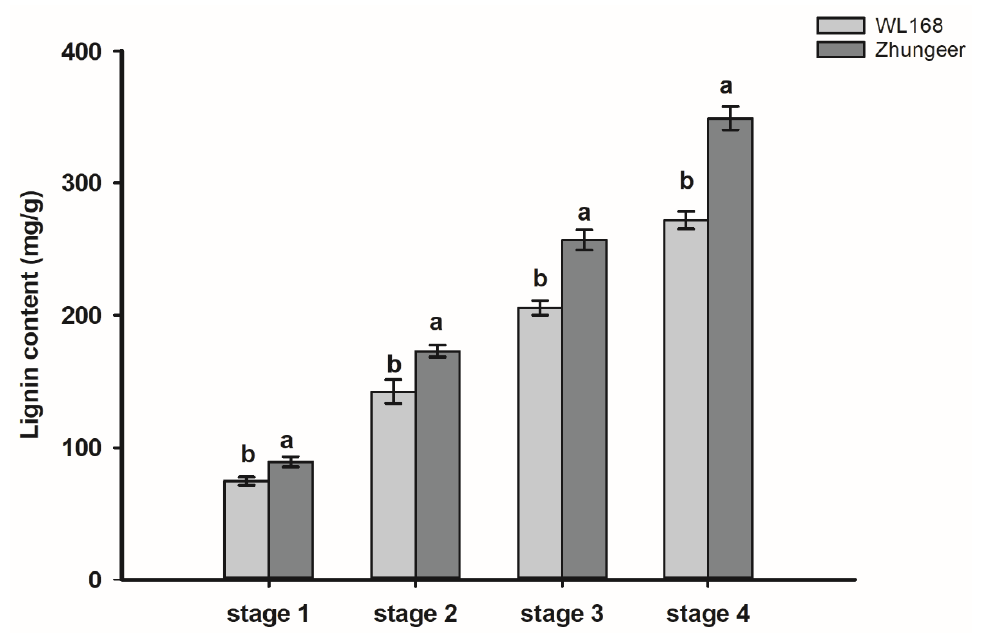
Figure 2. Lignin content of stems of two alfalfa cultivars in four developmental stages. Different letters indicate significant differences at p < letters indicate significant differences at p < 0.05.